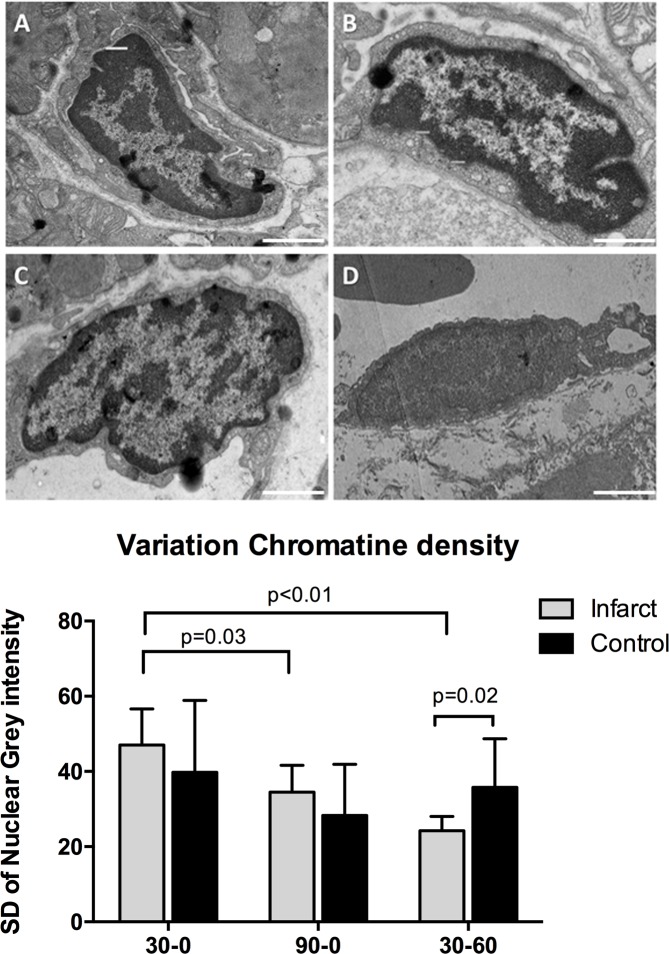
Endothelial cell nuclei characteristics.Top four images exemplify typical TEM images of infarct zone samples from different groups. A-D represent the control, and infarct zones of the 30–0, 90–0 and 30–60 group respectively. Magnification 12500x White bars represents 2 micrometer. E Quantification of chromatin density variation, using iTEM software.